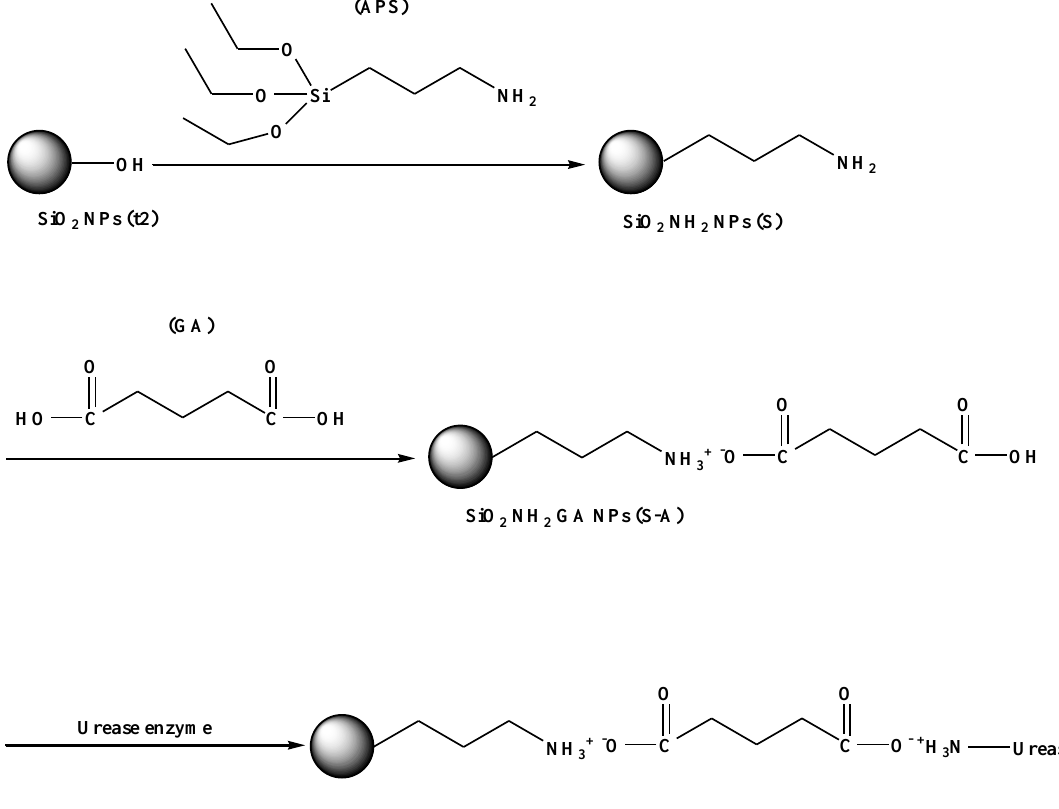
NPs biochemical surface 2